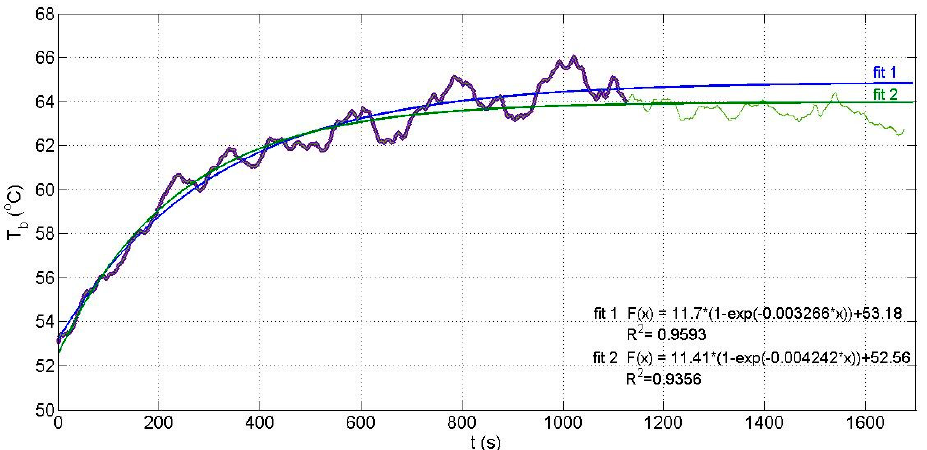
Figure 6. T b (t) profile SM55 module placed inclined over a window in a Building Adapted Photovoltaics (BAPV) configuration.